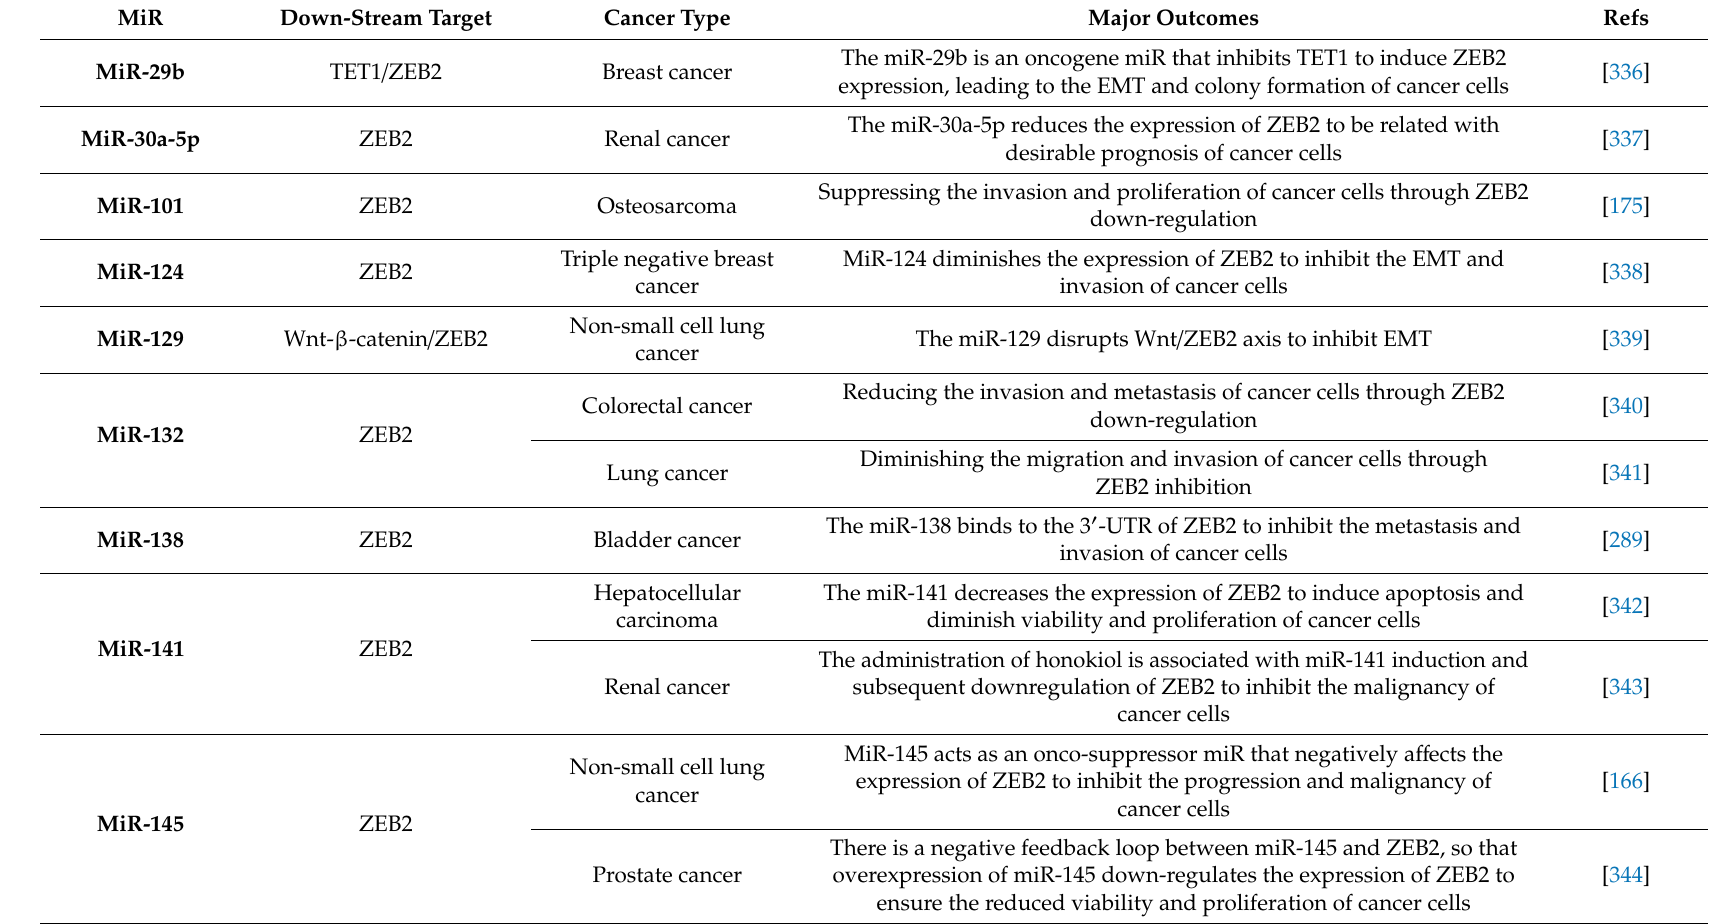
Table 4. ZEB2 regulation by miRs in di ff erent